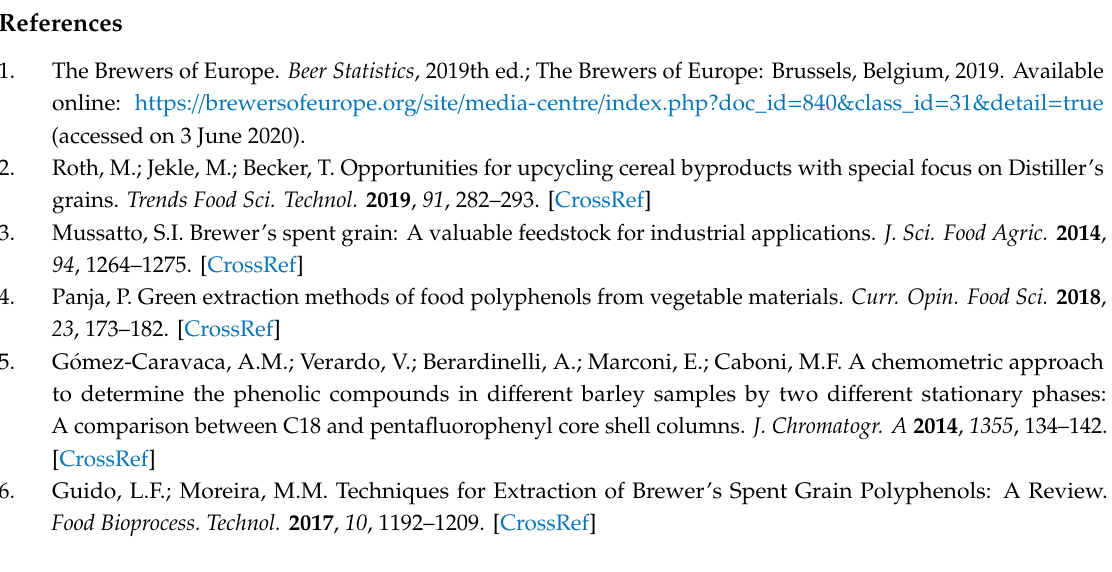
Figure S1: HPLC chromatogram of BSG extract, Tables S1–S11: Standard calibration